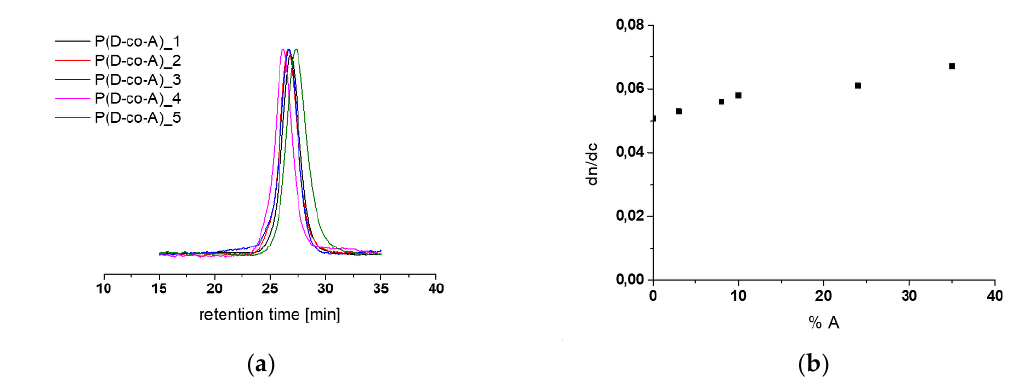
Figure 1. ( a ) GPC traces of copolymers (DMF, 1 mL/min); ( b ) the refractive index increments of P(D-